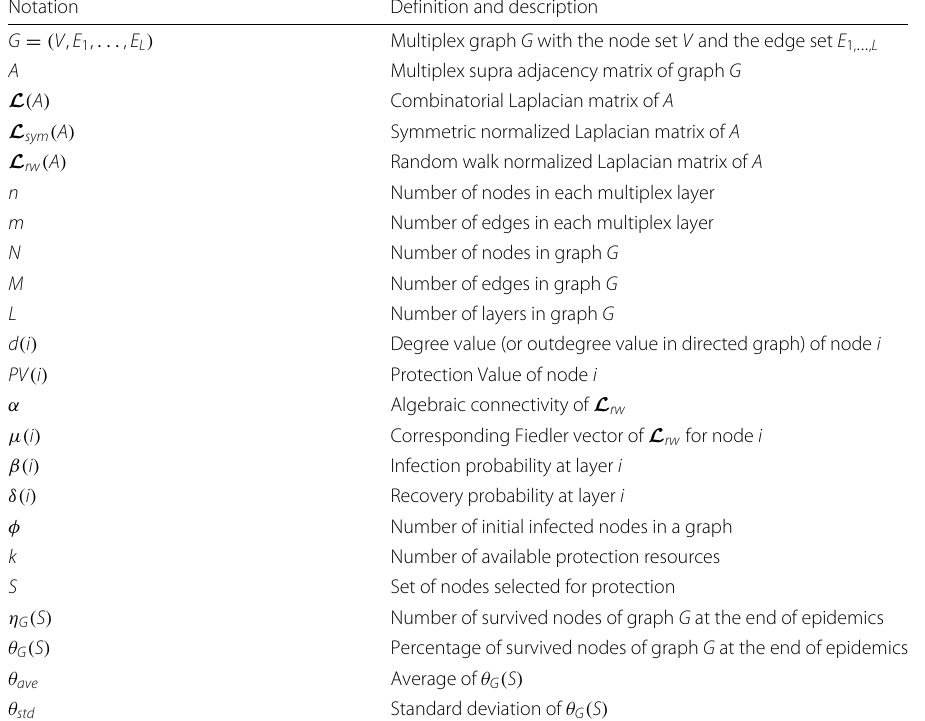
Table 1 Summary of terms and notations